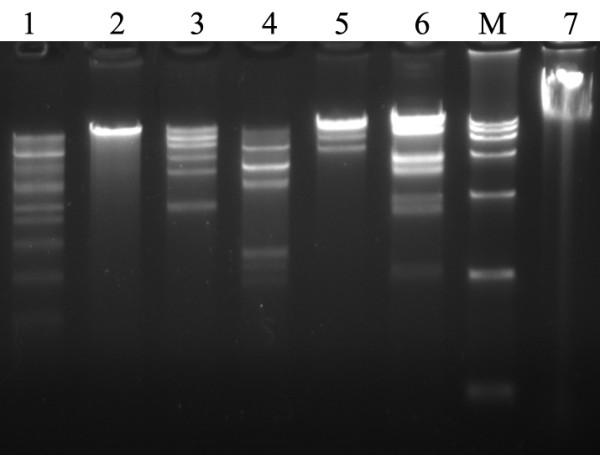
Restriction endonuclease digestion of HAdV7-gz07 virus genome. Products produced by restriction enzyme digestion of the genome of HAdV7-gz07. 1: BamHI; 2: EcoRI; 3: EcoRV; 4:HindIII; 5: SalI; 6: SmaI; 7: genome without digestion; M: DNA marker DL15000.